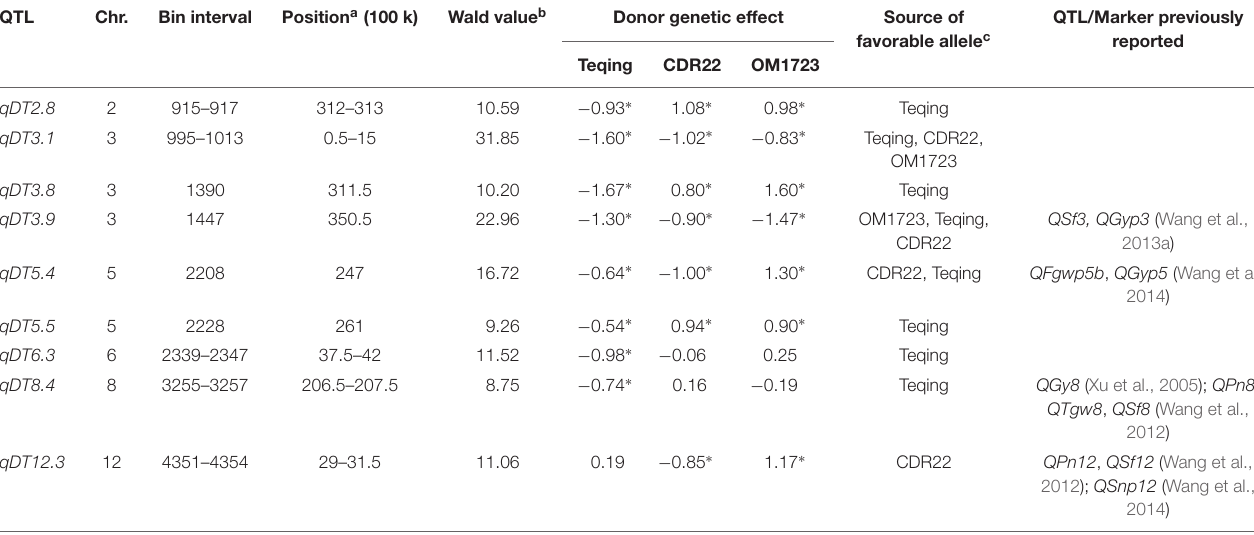
TABLE 1 | QTL results of DT detection via joint analysis of segregation distortion in three selected breeding populations. QTL